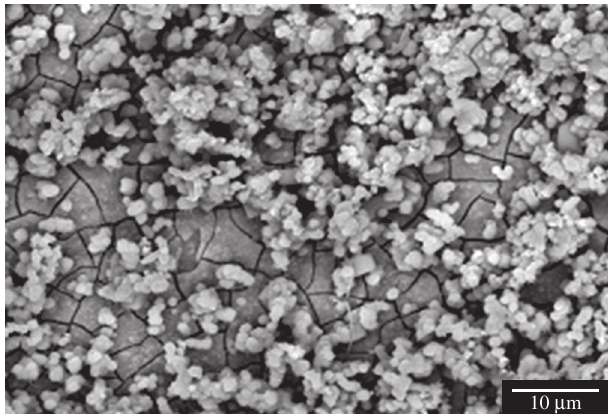
Figure 6. Scanning electron micrograph (SEM) of the silicon nitride surface coated by a hydroxyapatite layer, using SS as nucleant